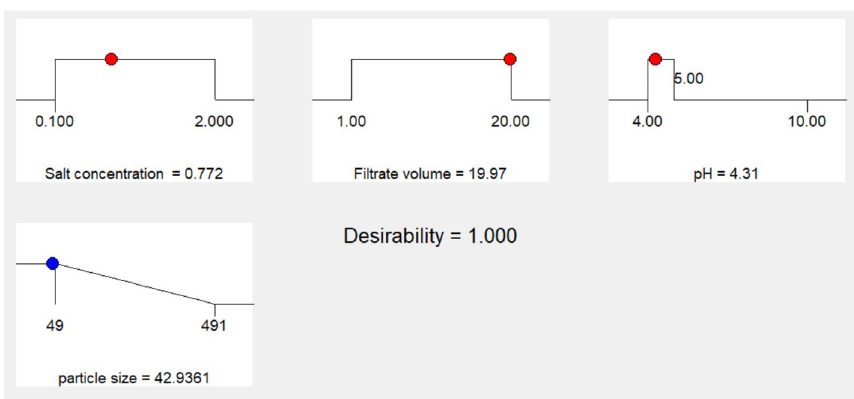
Figure 15. A predicted solution estimated by Box-Behnken design numerical optimization that used in validation of model to yield the smallest particle size.